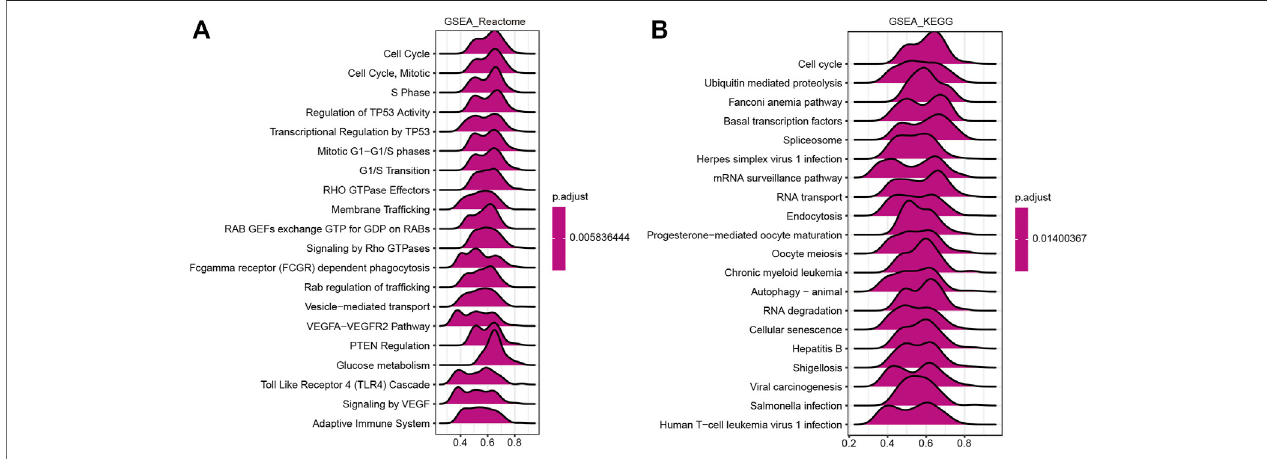
FIGURE 7 | Merged enrichment plots from GSEA. (A,B) Merged plots showing the pathways associated with HSF2 expression based on Reactome and KEGG analyses of